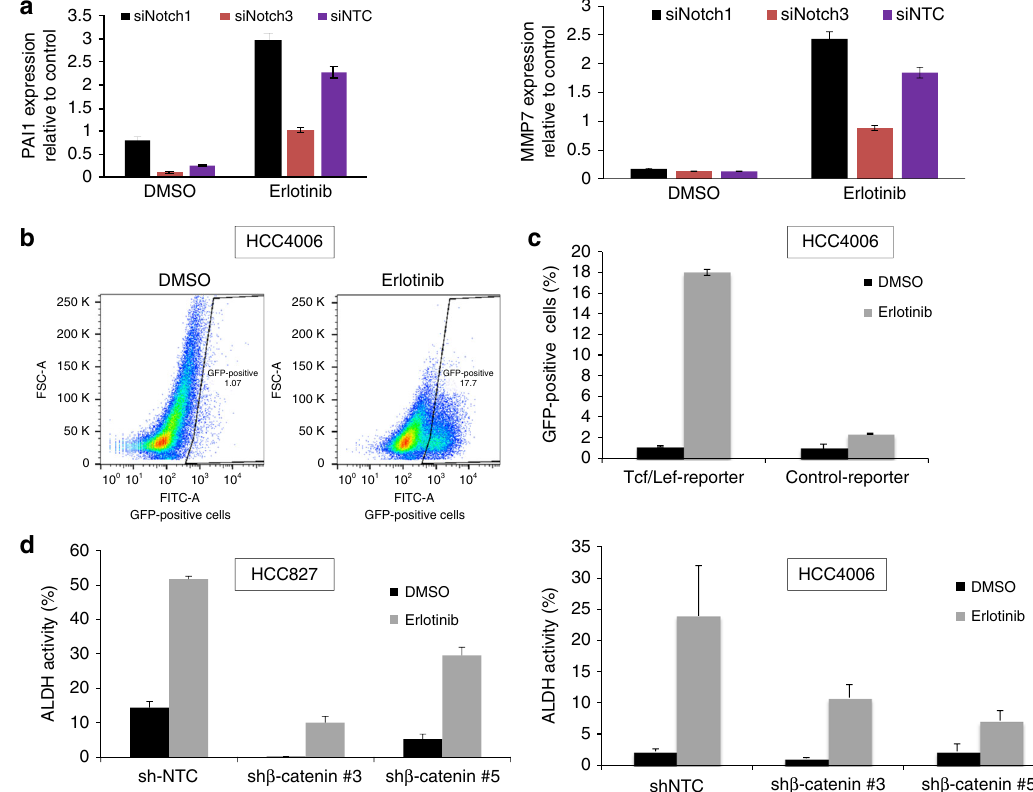
Fig. 1 Identi fi cation and validation of regulators of EGFR TKI-mediated DPCs in EGFR mutant NSCLC cells. a qRT-PCR validation of PAI1 and MMP7 expression levels in HCC4006 cells. b HCC4006 cells expressing Tcf/Lef-GFP reporter were treated with DMSO or 0.1 μ M erlotinib for 6 days and sorted by FACS for GFP fl uorescence. c Histograms and quanti fi cation from triplicates was plotted and include a negative control with mutated Tcf/Lef consensus binding sites. The mutant reporter has no activity after erlotinib treatment. DMSO-treated cells were used as a base line control. d HCC827 (left) and HCC4006 (right) were stably infected with shRNAs targeting non-targeting control (shNTC) or β -catenin (shRNAs #3 and #5) were treated with DMSO or erlotinib and subjected to ALDH assay. For ( a ) and ( c ) error bars represent SD from biological triplicates. For ( d ) error bars represent SD from